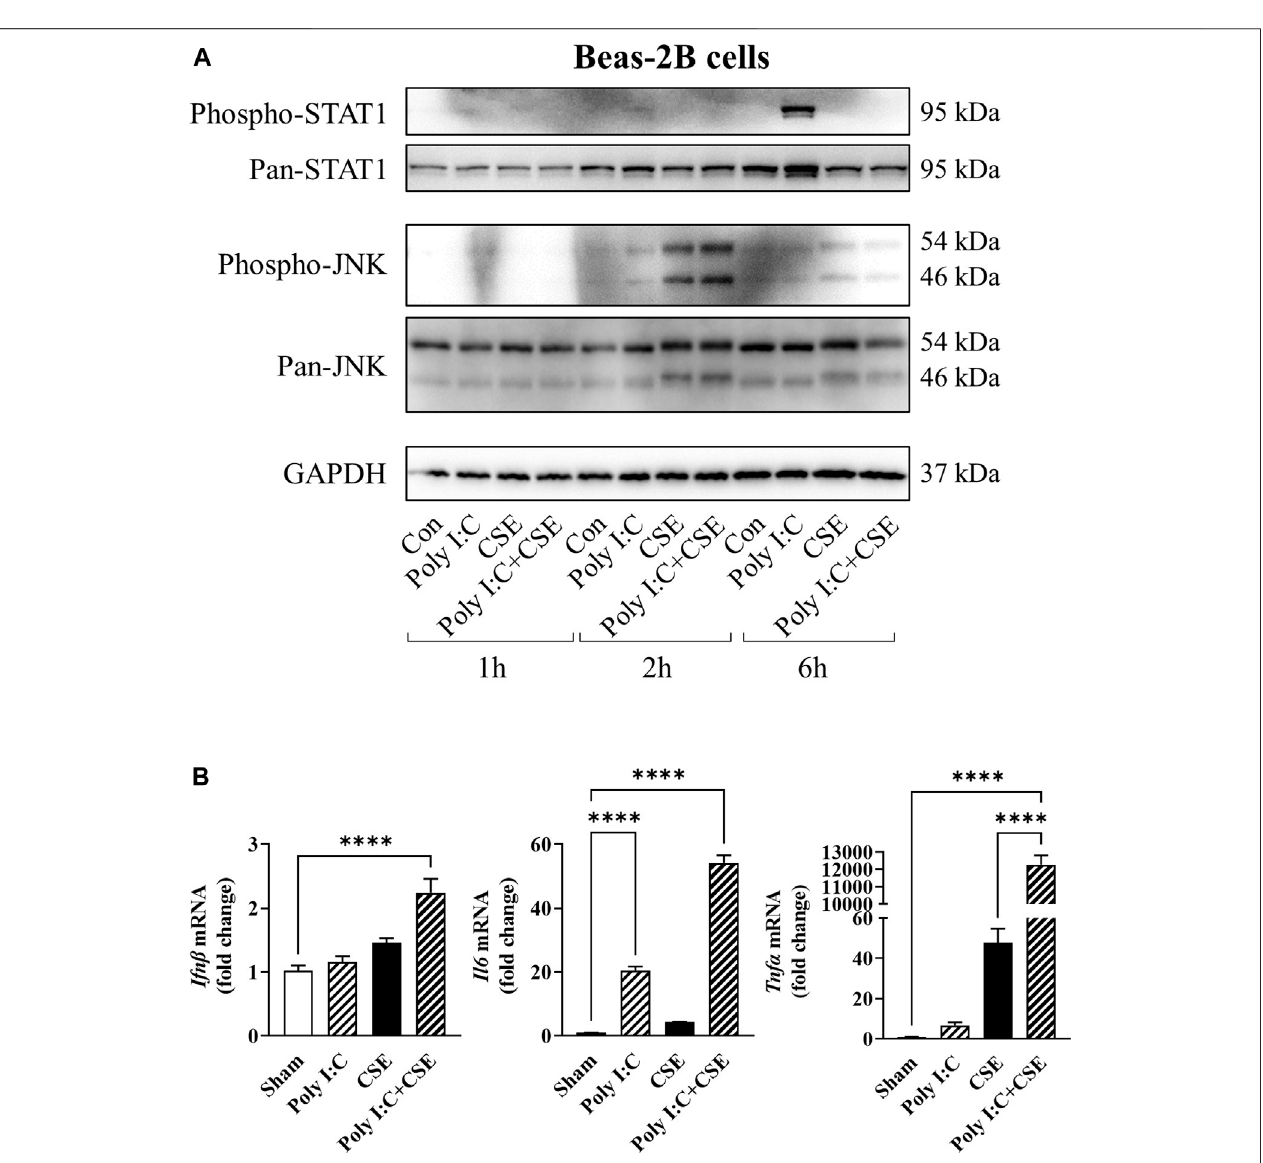
FIGURE 6 | Effect of CSE and poly I:C on in fl ammatory response of lung epithelial cells. BEAS2B cells were exposed to polyinosinic:polycytidylic acid (poly I:C), 25% cigarette smoke extract (CSE), or a combination of the two for 1, 2 and 6 h. (A) Western blot images of phospo-STAT1, pan-STAT1, phospho-JNK and pan-JNK. (B) qPCR analysis was performed to assess expression of in fl ammatory markers Ifn β , Il6 and Tnf α . Data shown as mean +SEM ( n = 7 – 9 per group). **** p < 0.0001.